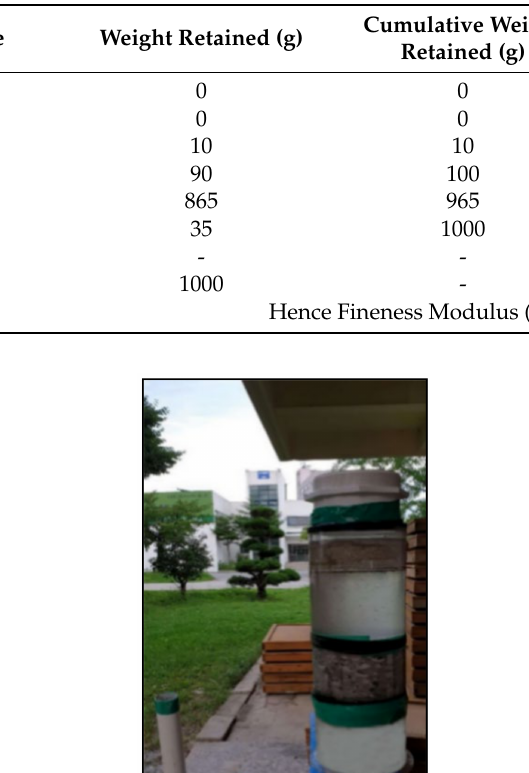
Table 3. Sieve analysis of fine aggregate (10 mm).